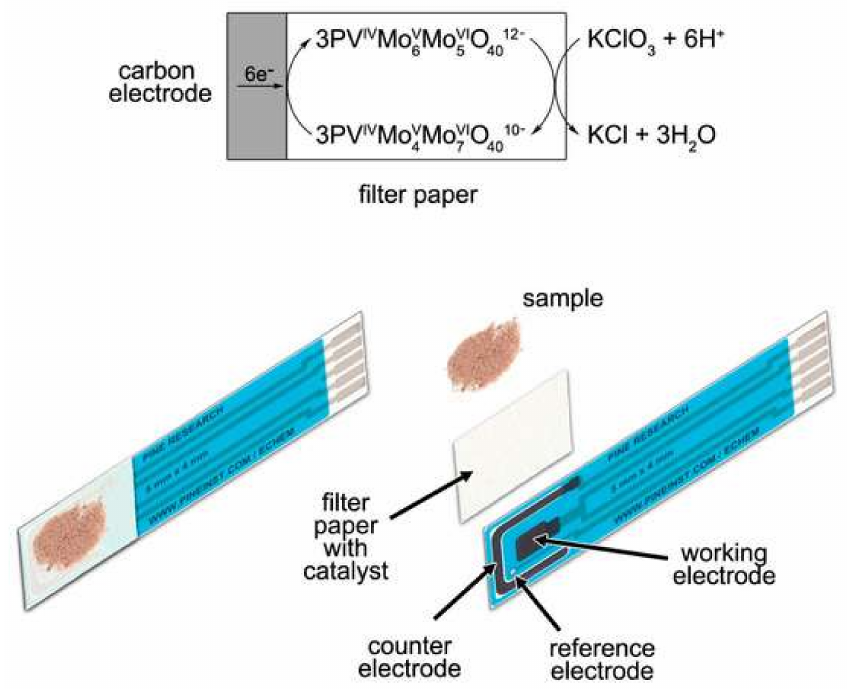
Figure 6. Paper-based electrochemical detection of chlorate. (Reproduced from Ref. [131], an